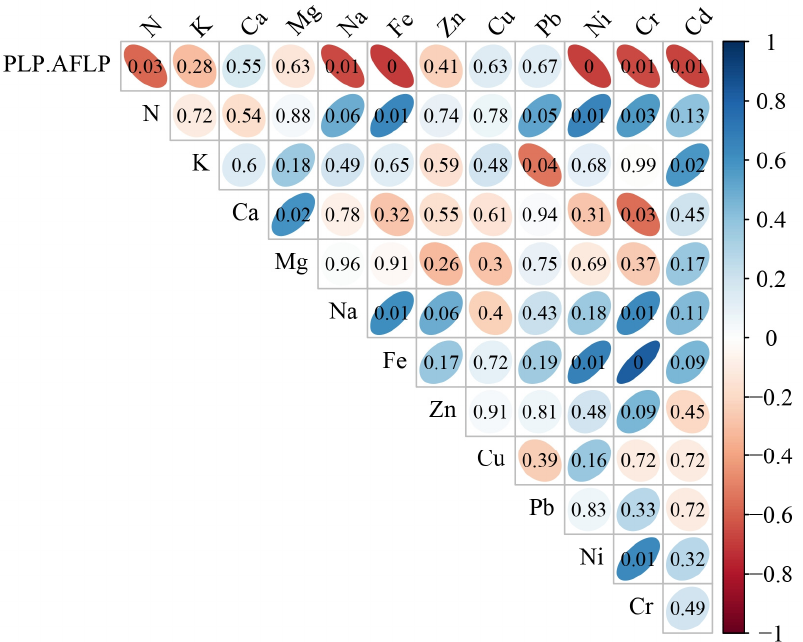
Figure 6. The correlogram of Spearman rank correlation coefficients (Rs) (from − 1 to 1) for all pairs of variables of Lythrum salicaria populations. Blue color represents positive and red color, negative, correlations. Color intensity indicates the strength of correlation, so the stronger the correlation, the darker the figures. Correlation numbers inside colored figures indicate level of significance; thin ellipsoid figures show significance ( p < 0.05) while figures towards a spherical shape show insignificant correlations. PLP.AFLP—percentage of amplified fragment length polymorphic loci. N, K, Ca,